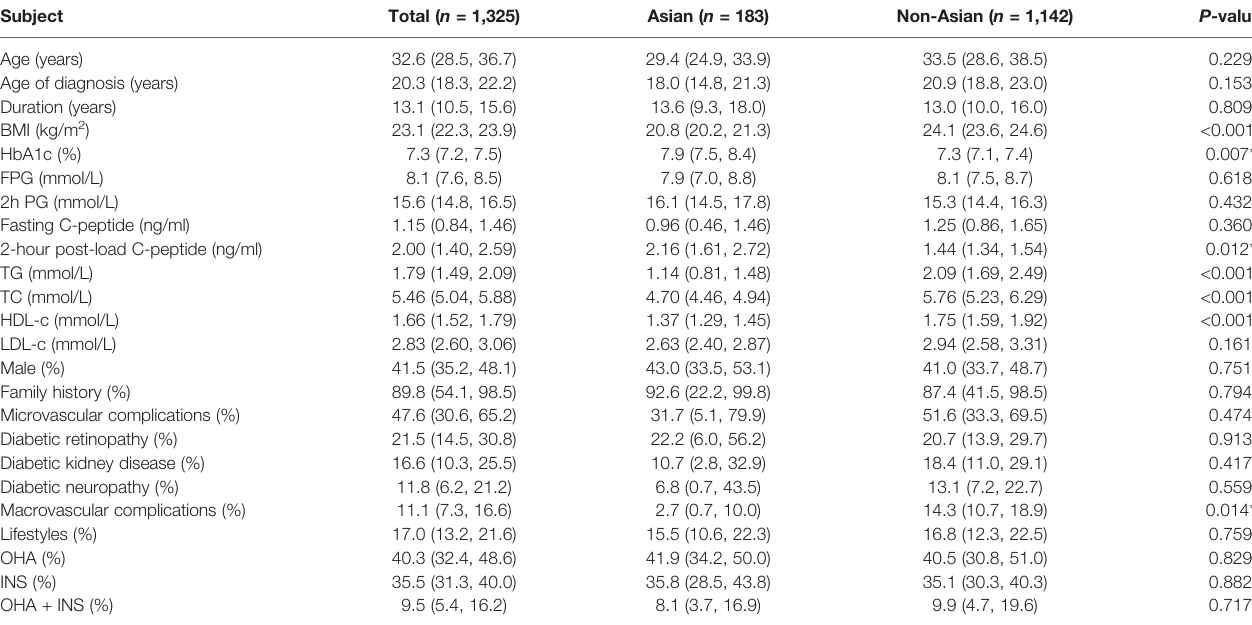
TABLE 1 | Characteristics of patients with HNF1-alpha MODY by geographical